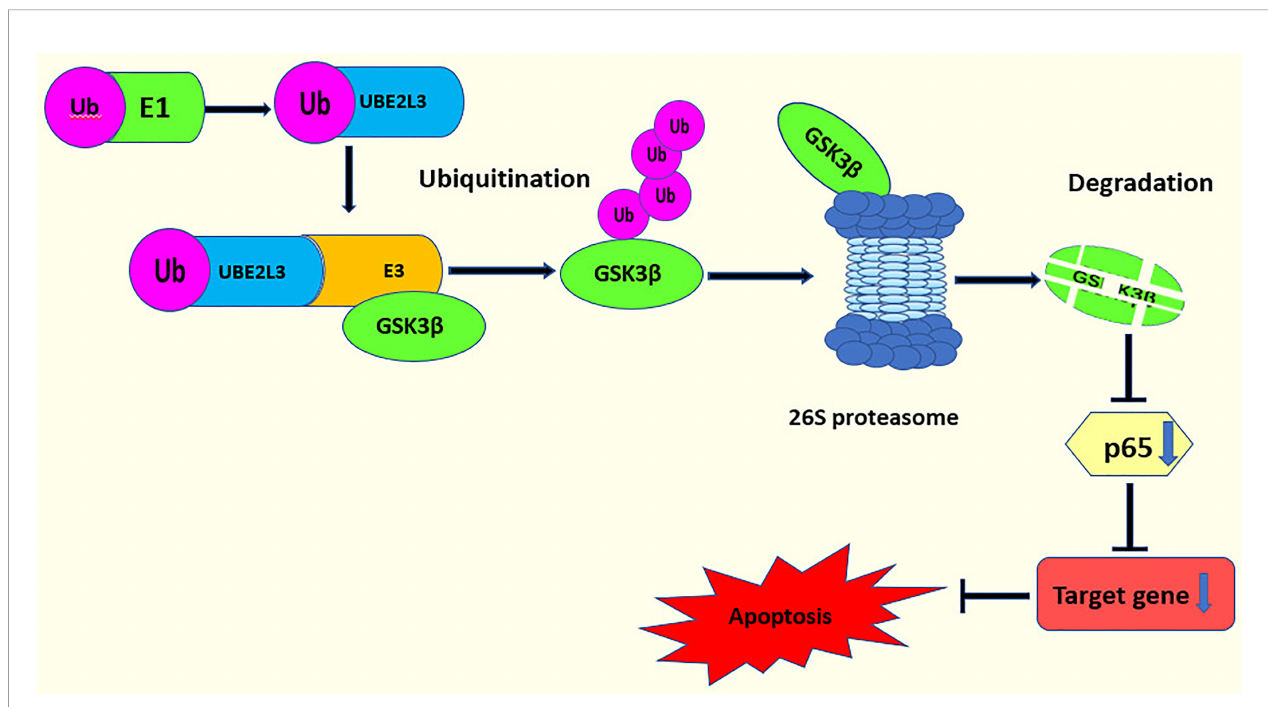
FIGURE 4 | UBE2L3 acts on the GSK3 b /p65 signaling pathway. UBE2L3 participates in the ubiquitination of GSK3 b and promotes the degradation of GSK3 b , leading to a decrease on the expression of p65, thereby inhibiting